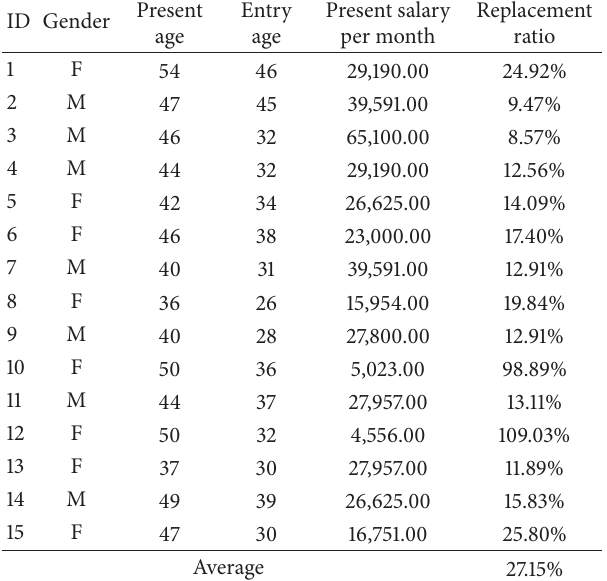
Table 7: Replacement ratio for hybrid pension